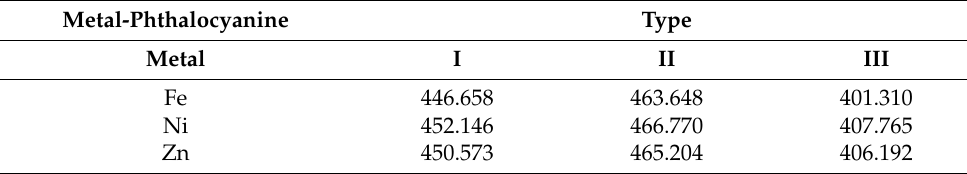
Table 6. Connolly solvent-excluded volume (Å 3